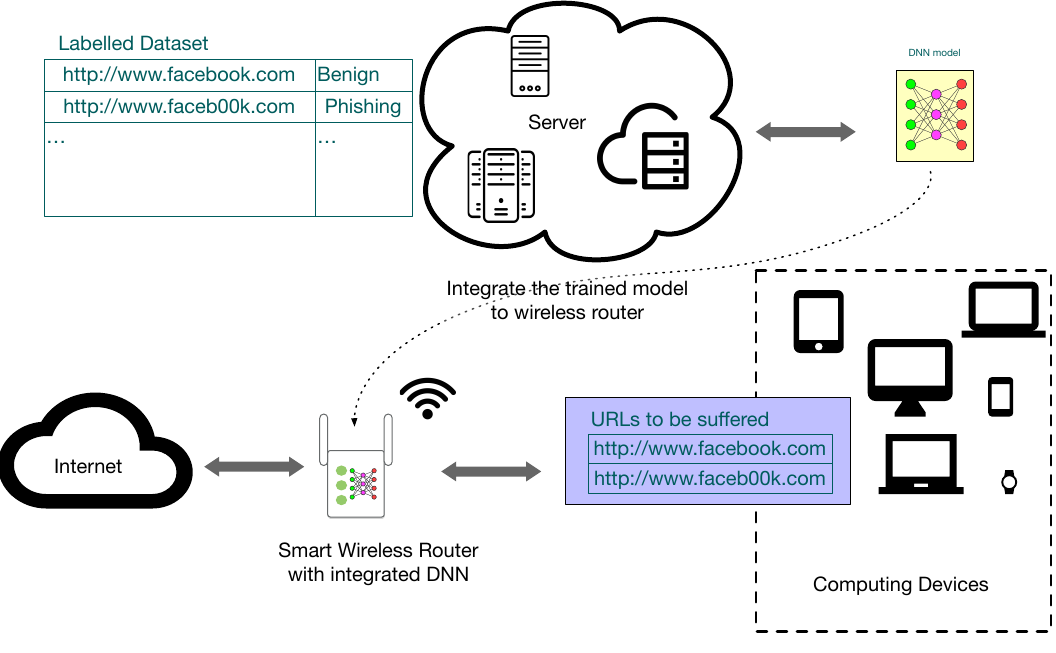
Figure 11. The implementation process.